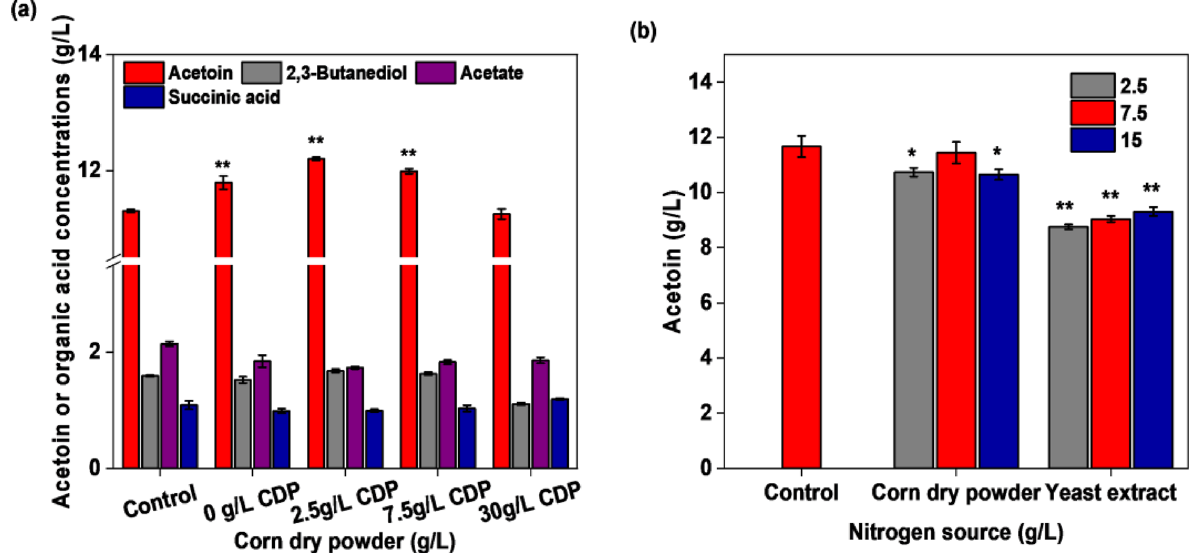
Fig. 6 a Production of acetoin using okara enzymatic hydrolysate as carbon source in conjunction with different amounts of corn dry powder (CDP). Control: okara enzymatic hydrolysate as the carbon source, 15 g/L corn dry power. b Comparison of acetoin fermentation between okara hydrolysate (29 g/L reducing sugar) supplementation of 3 g/L urea and containing 3 g/L urea simulating okara hydrolysate sugar composition (29 g/L reducing sugar), supplemented with (2.5, 7.5, 15 g/L) corn dry powder and (2.5, 7.5, 15 g/L) yeast extract, respectively. Control: okara enzymatic hydrolysate as the carbon source, 3 g/L urea (*Significance code: p < 0.05, **Significance code: p < 0.01)